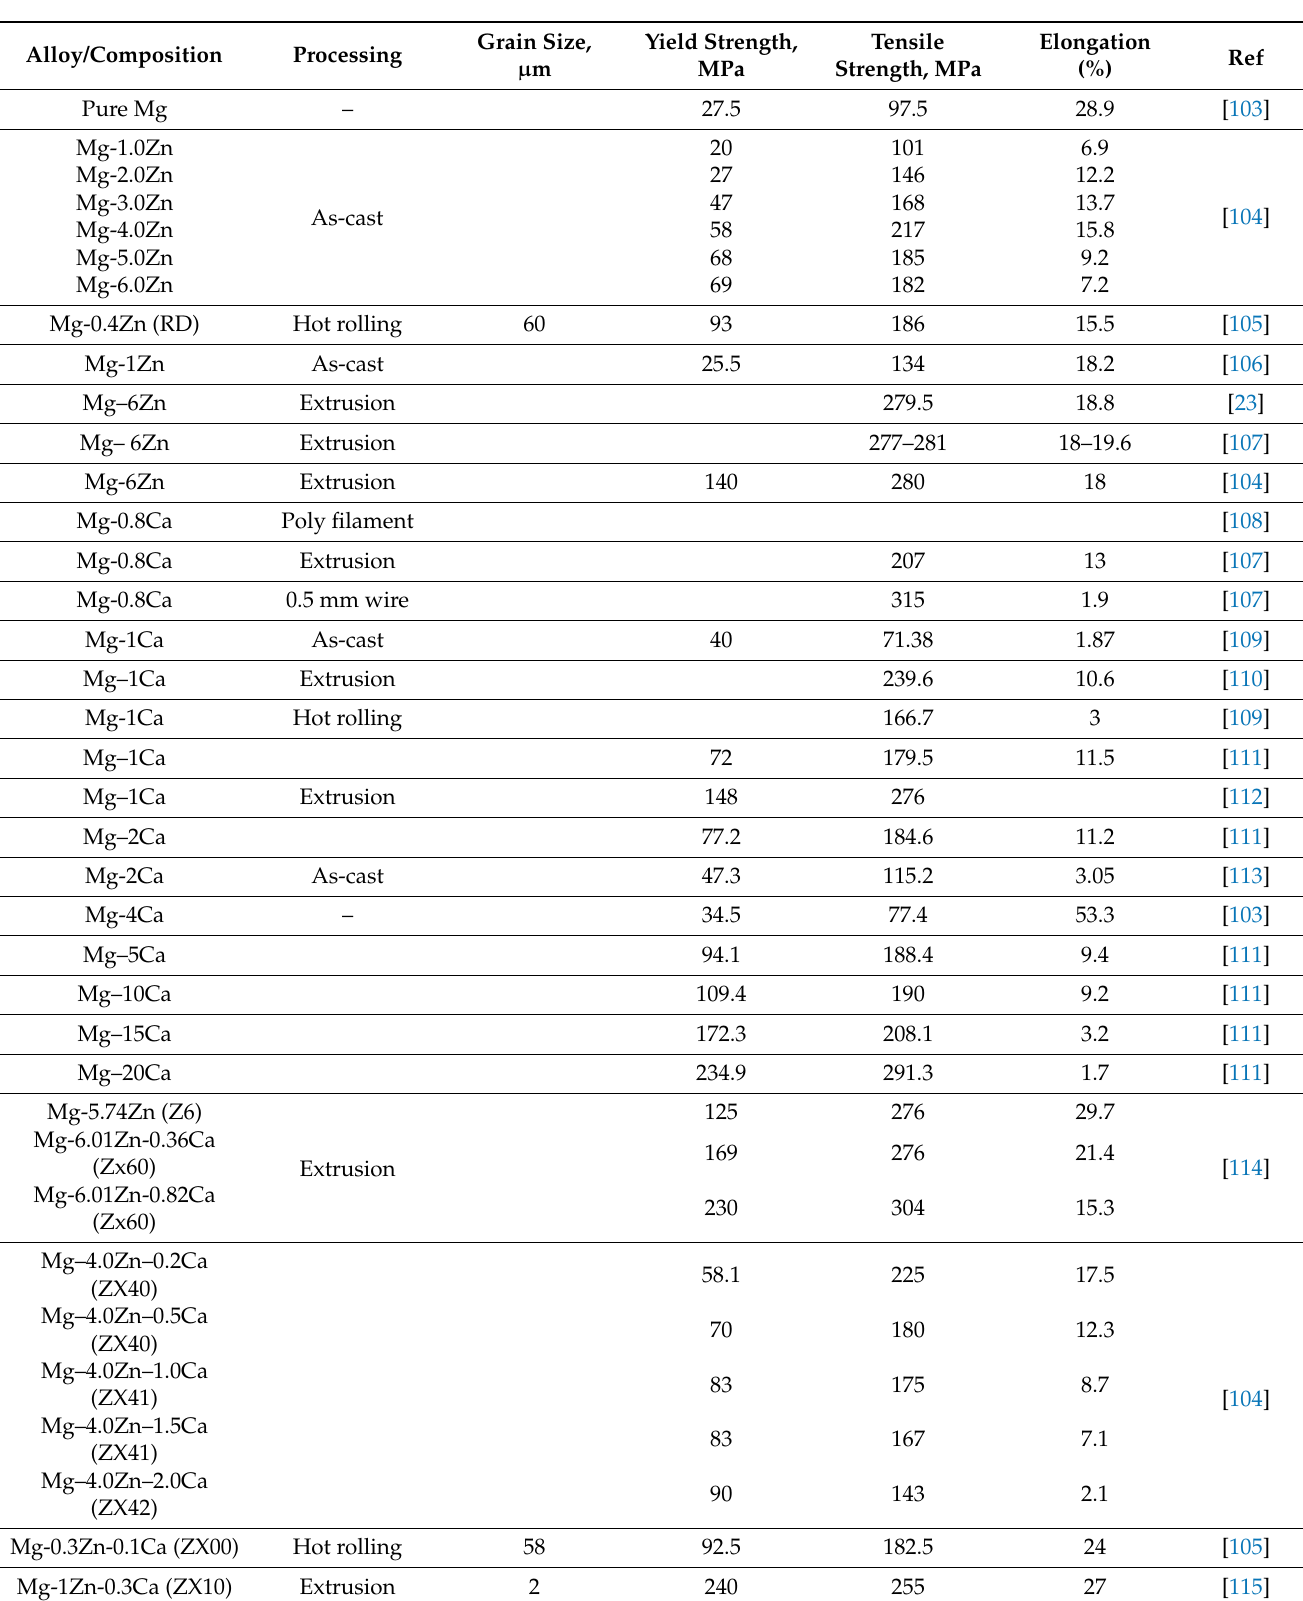
Table 2. Mechanical properties of Mg-Zn-Ca